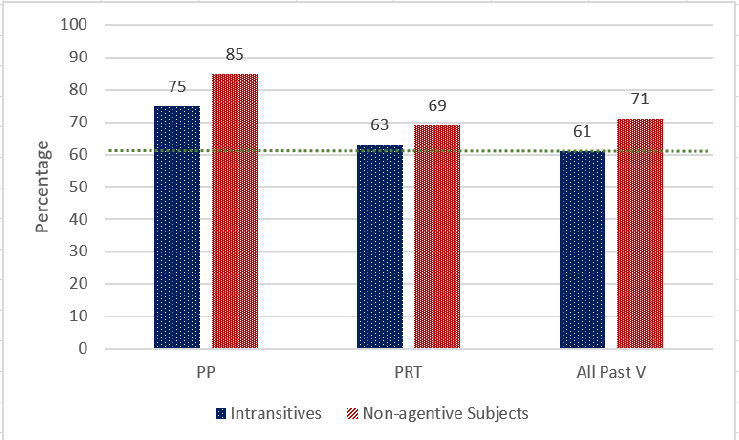
Source: Data extracted from